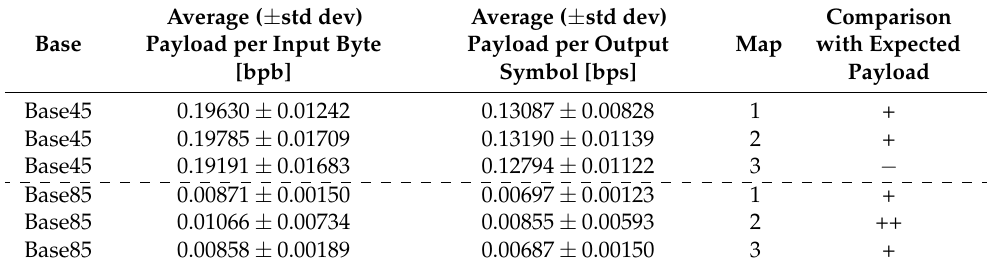
Table 5. Results of the Base45 and Base85 encodings applied to 75 compressed files (format